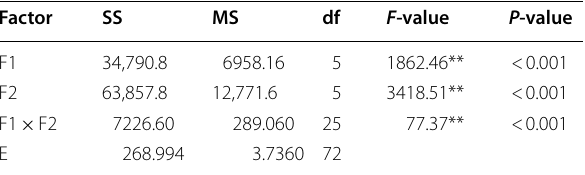
F1: spore density, F2: day, F1 F2: interaction between F1 and F2, E: error × *indicates the difference between values, in a word, the values have significant to be measured and used for research